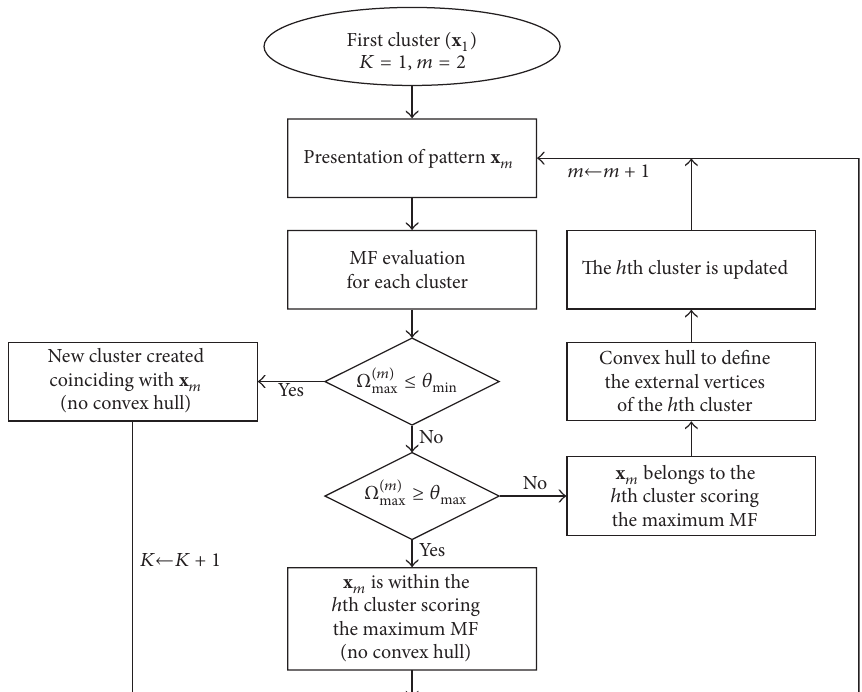
Figure 2: Flowchart of the proposed CH algorithm; the evaluation of MFs is illustrated in Section 5 considering the two alternative options (9) or